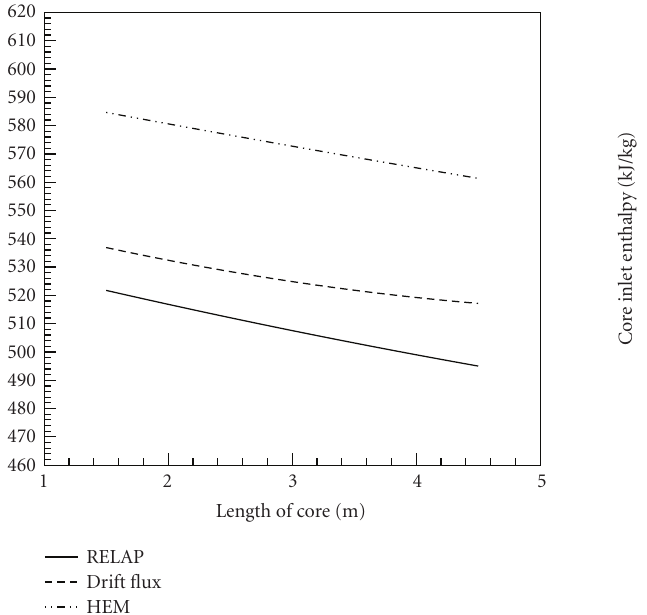
Figure 5: Variation of mass flow rate with core length.